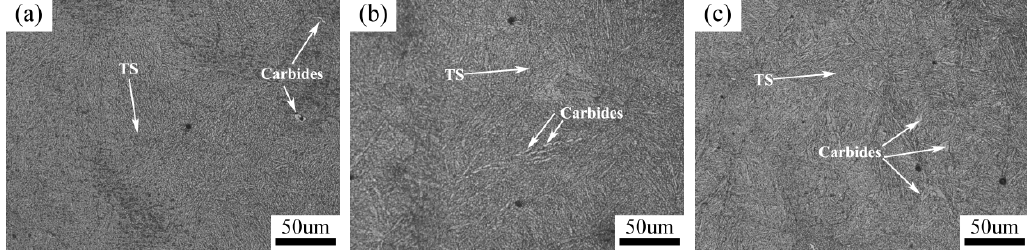
Figure 14. Microstructure of tempering zone at different heat inputs. ( a ) 4.2 kJ/cm, ( b ) 5.4 kJ/cm, and